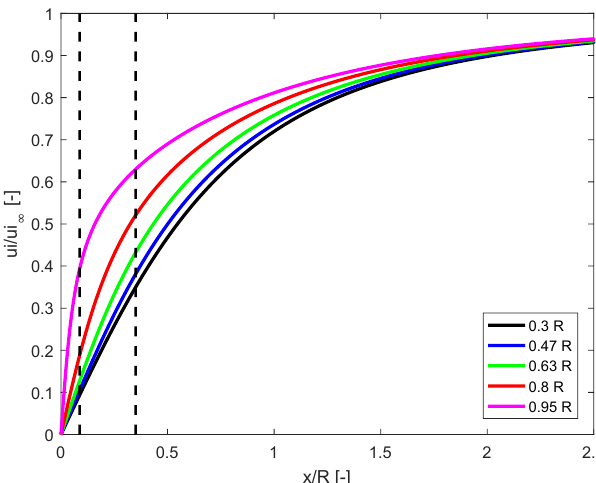
Figure 3. Normalized induced velocity at different radial stations depending on the length of the vortex wake behind the rotor plane. The dashed lines correspond to a time instant t = 0 . 35s when the wake velocity is 1.25ms − 1 (left vertical line, corresponding to a = 0 . 5) and 5ms − 1 (right vertical line, corresponding to a = 0 .